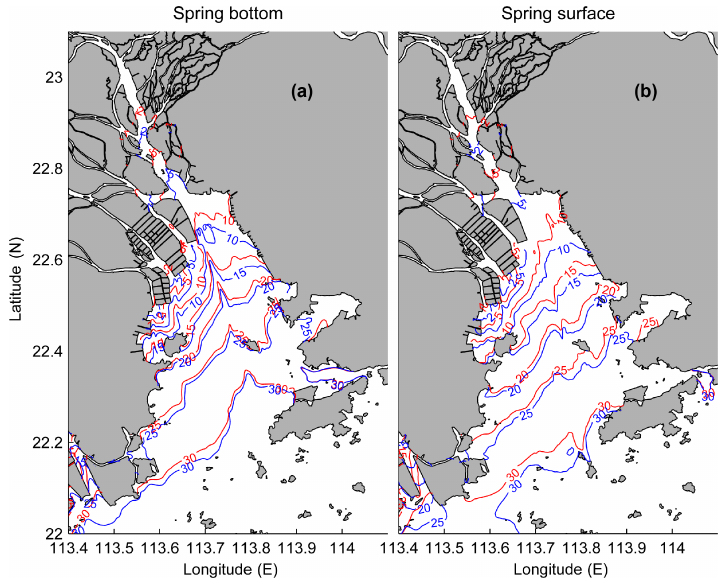
Figure 9. Comparison of salinity during the spring tide for Cases 1 (blue contour) and Case 3 (red contour). Panel (a) the bottom; panel (b) the